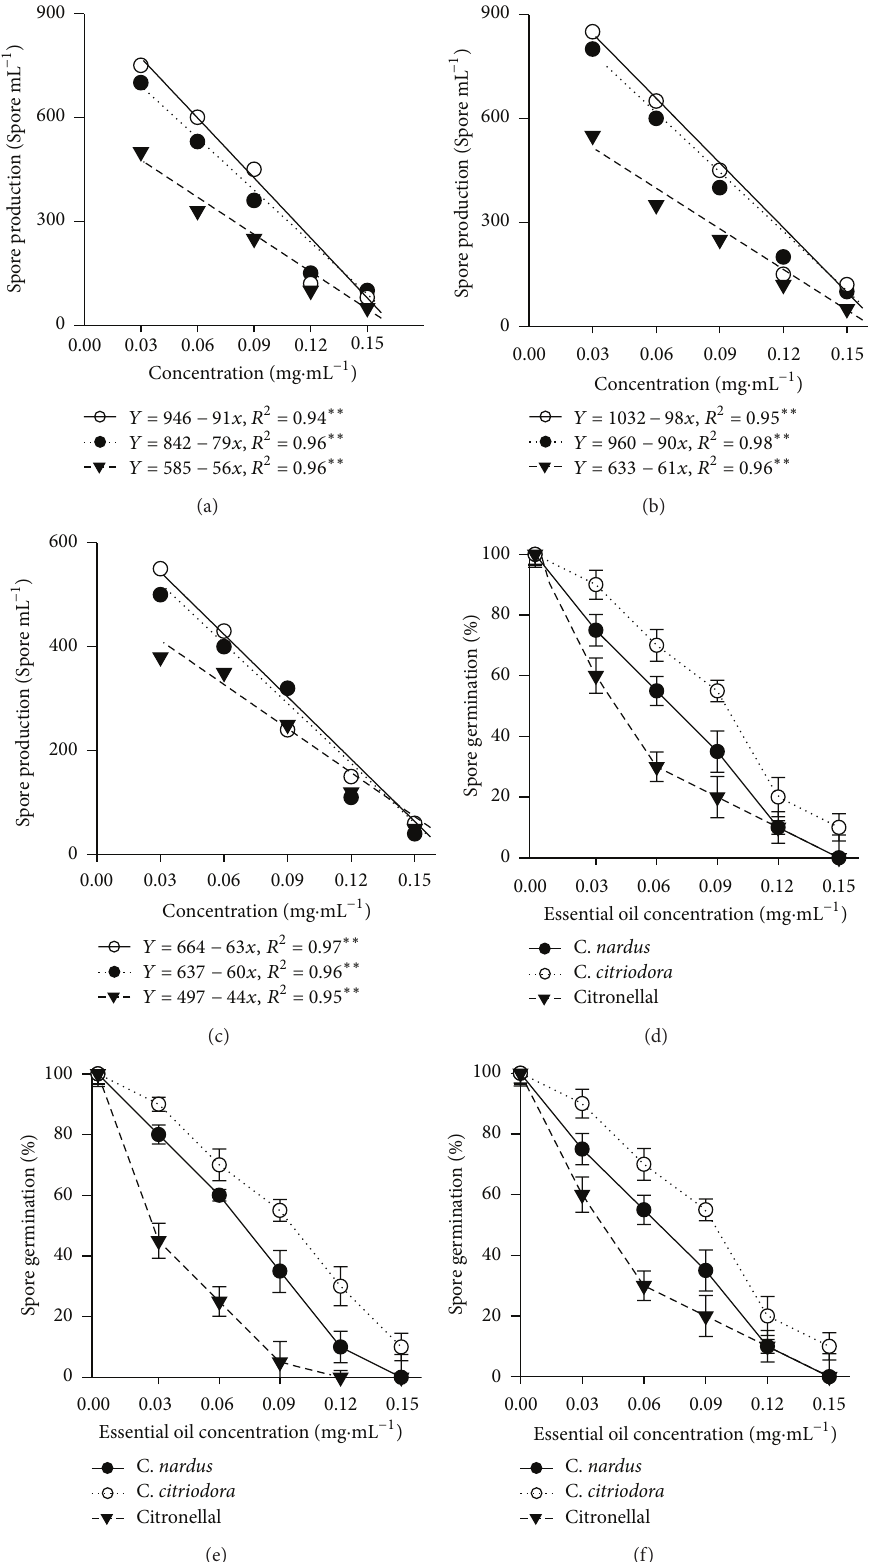
Figure 2: Effects of volatile compounds of C. nardus , C. citriodora, and the major constituent citronellal in the sporulation of P. grisea (a), Aspergillus spp. (b), and C. musae (c). Volatile effects of C. nardus , C. citriodora , and citronellal on spore germination (%) of P. grisea (d), Aspergillus spp. (e), and C. musae (f), 14 days after